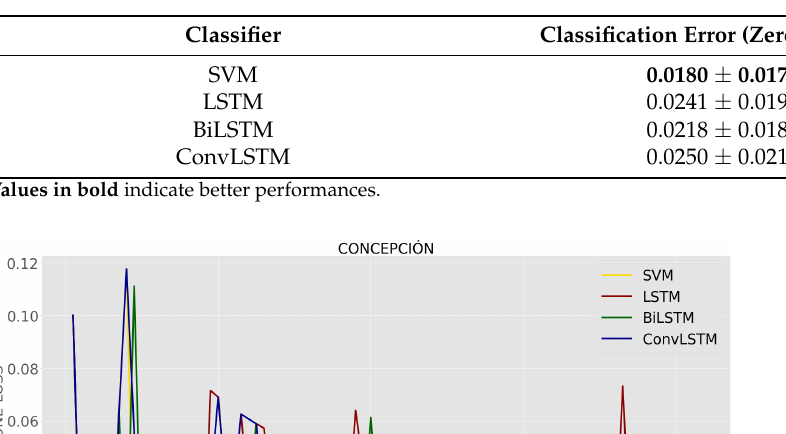
Table 3. Average classification error results.